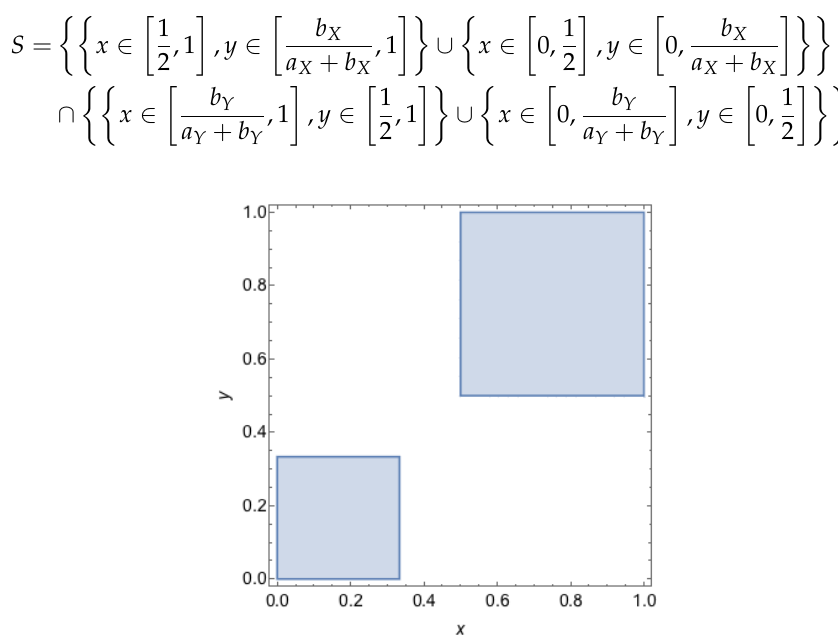
Figure 7. Set of QRE-achievable states for Example 2. A point ( x , y ) represents a mixed strategy profile where the first agent chooses its first strategy with probability x and the second agent chooses its first strategy with probability y . The grey areas depict the set of mixed strategy profiles ( x , y ) that can be reproduced as QRE states for Example 2, i.e., these are outcomes for which there are temperature parameters ( T x , T y ) for which the ( x , y ) mixed strategy profile is a QRE.